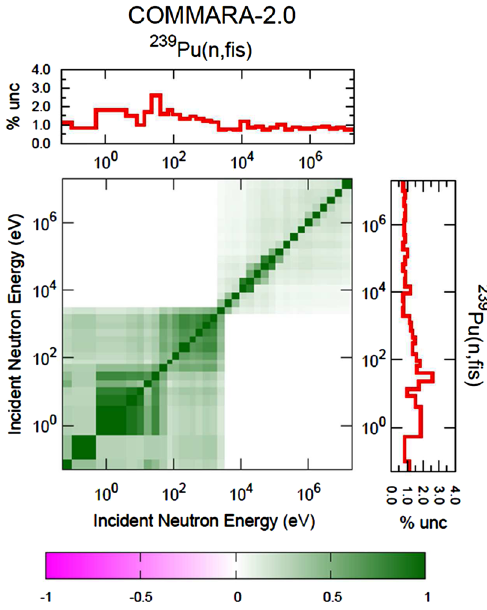
Fig. 1. 239 Pu fi ssion uncertainty and energy correlation: